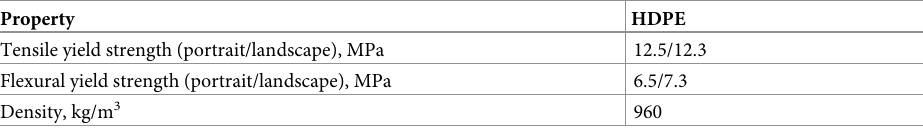
Table 3. Test report of HDPE provided by the